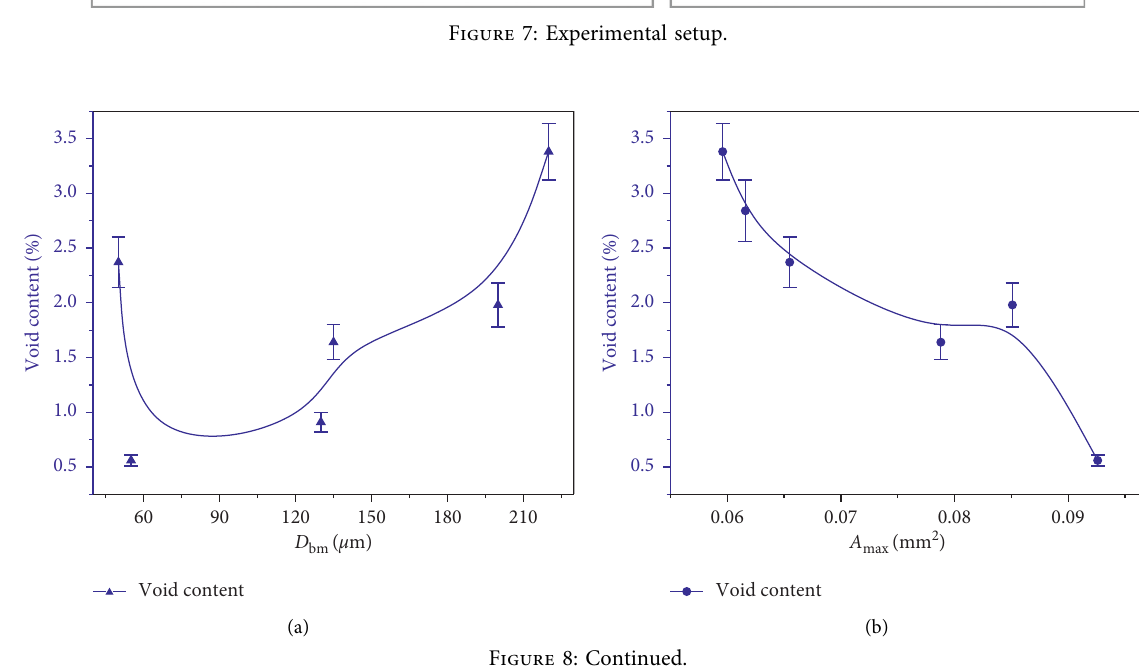
Figure 7: Experimental setup.